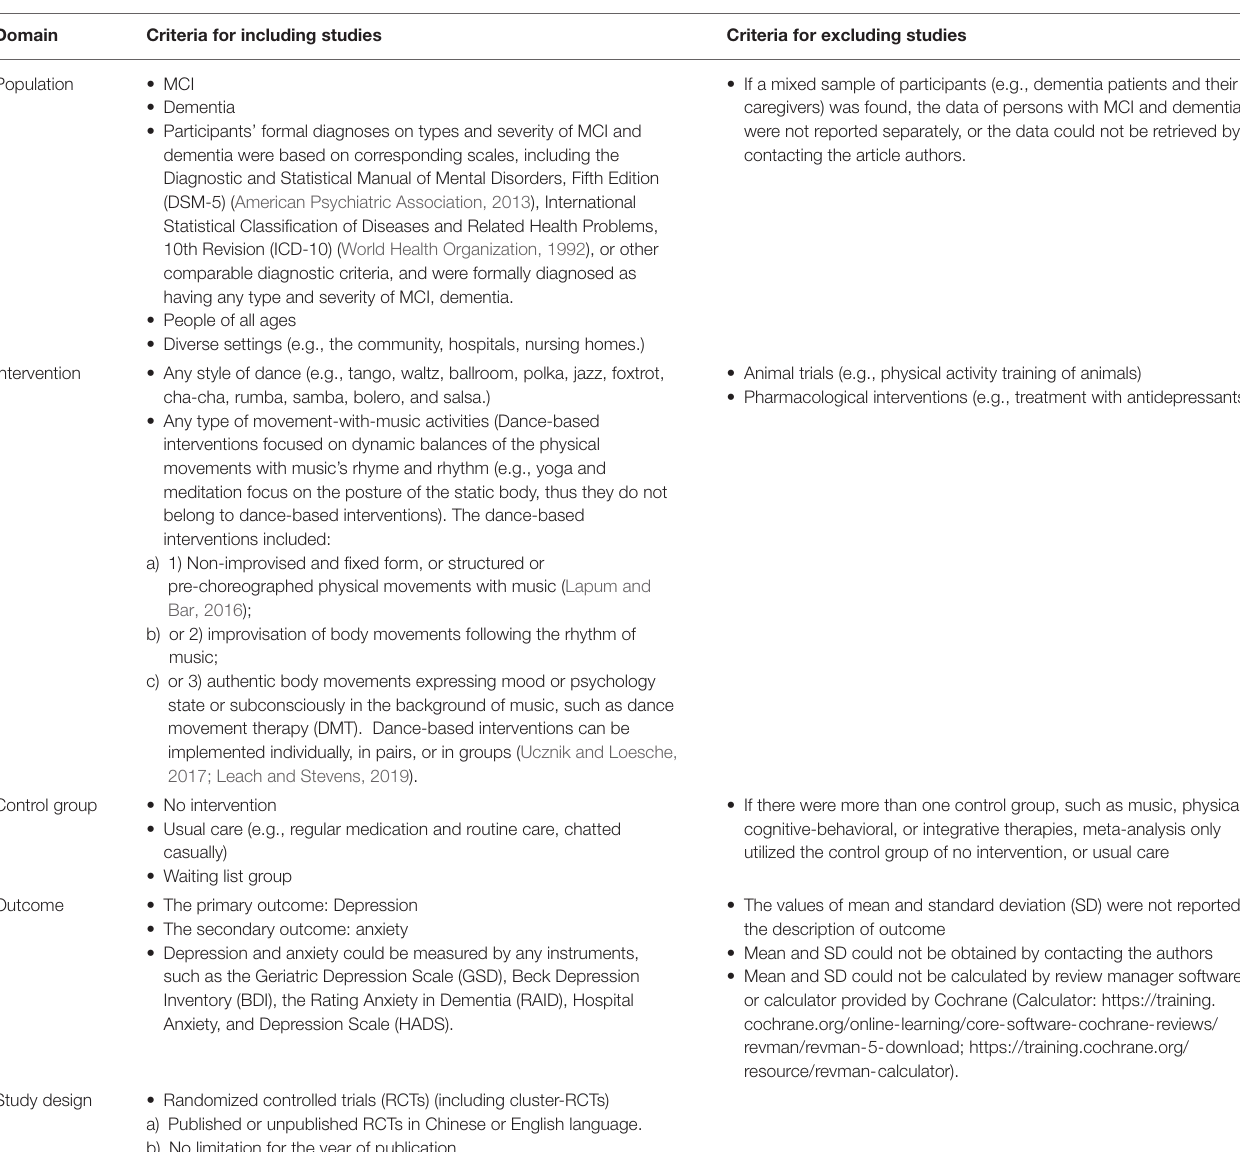
TABLE 1 | Criteria for including and excluding studies. Domain Criteria for including studies Criteria for excluding studies